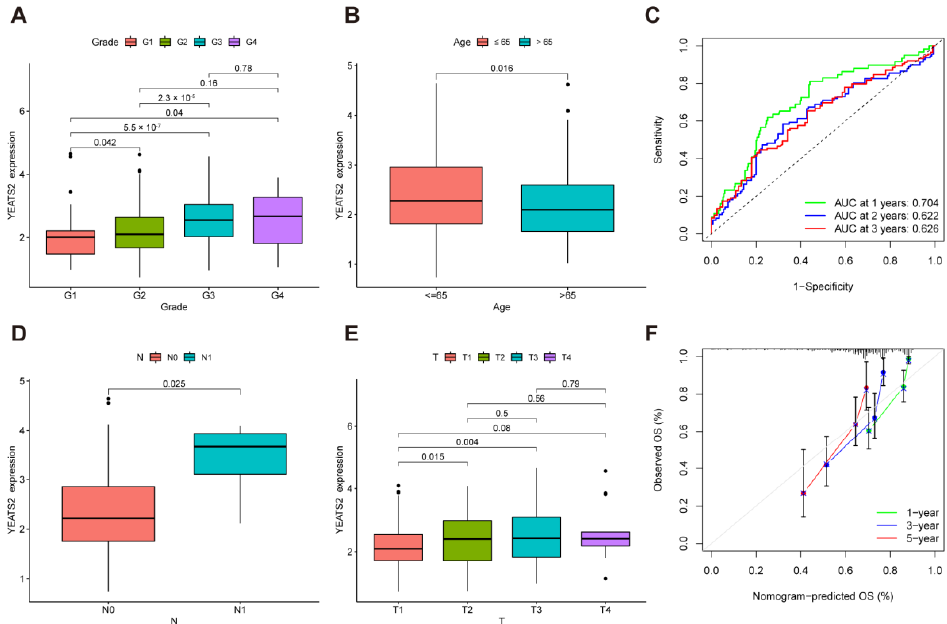
Figure 2. Correlation analysis between YEATS2 expression and clinical features of liver cancer. ( A ) Relationship between YEATS2 expression and grades. ( B ) Relationship between YEATS2 expres- sion and ages. ( C ) Time-dependent ROC analysis of YEATS2. ( D ) Relationship between YEATS2 expression and lymph node metastasis. ( E ) Relationship between YEATS2 expression and T stages. ( F ) Nomogram analysis of YEATS2. Data are presented as median and interquartile ranges.